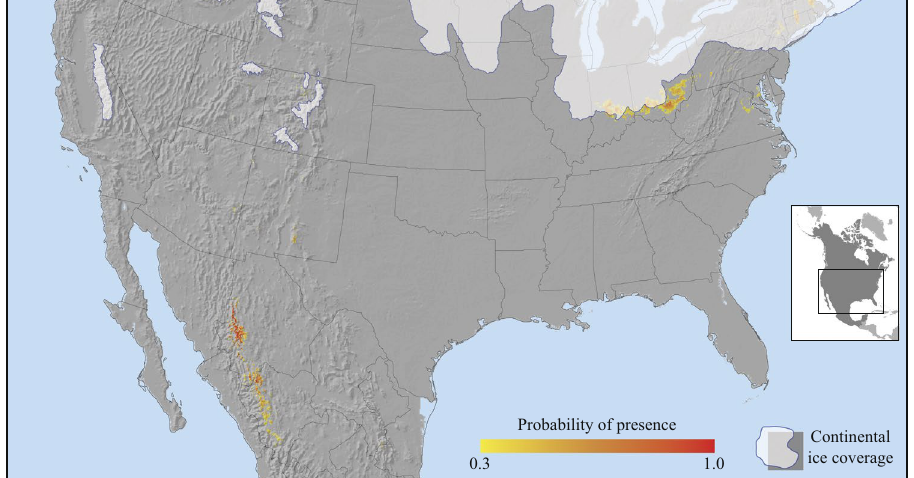
Figure 5. Probabilities of geographic locations in which aspen clones may have persisted through multiple glaciations. Data points were derived by multiplying the probability of presence estimates of the 1961–1990 reference climate with the 21,000 years before present period. The map was created with ArcGIS v9.3 (http://